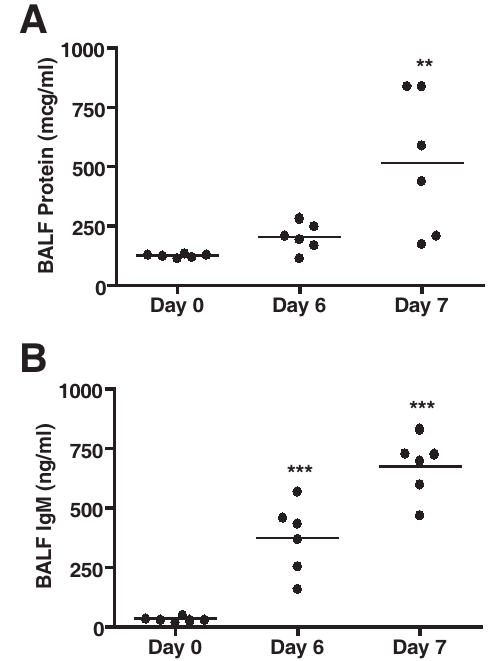
Figure 1. C57BL/6 Mice infected with PbA develop ALI. C57BL/6 mice infected with 1 6 10 6 PbA parasites were examined for lung damage once they exhibited marked parasitemia (day 6 and 7) but before they showed cerebral symptoms (n=6/group/experiment, representative of two independent experiments). A. Total protein concentration is significantly elevated in the BAL of PbA infected mice at Day 7 post infection (one-way ANOVA with Bonferroni’s multiple comparison correction, **p , 0.01). B. IgM concentrations are signif- icantly elevated over baseline levels in the BAL fluid at both Day 6 and 7 of PbA infection (***p , 0.001). Increased levels of BALF total protein and IgM are consistent with the development of pulmonary vascular leak and a disruption of the alveolar-capillary membrane that occur during ALI.